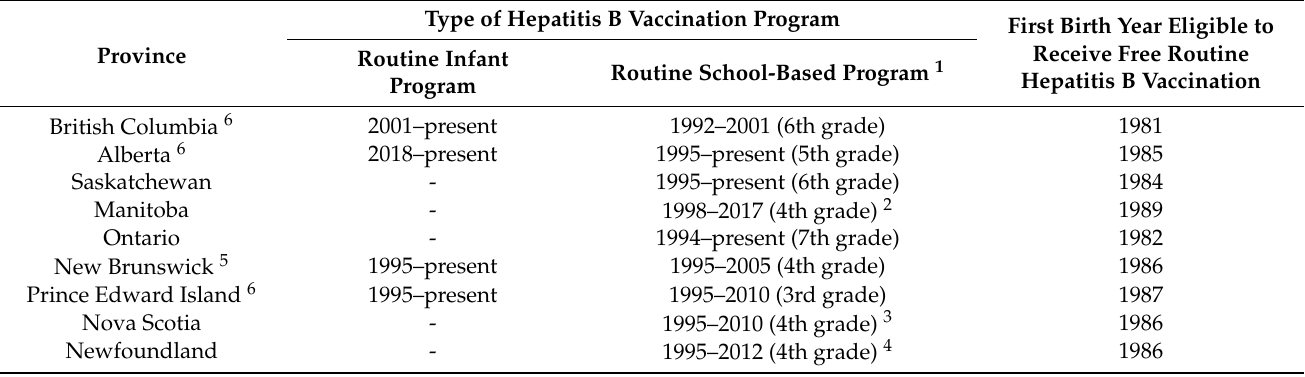
Table 1. Calendar years when free routine hepatitis B programs have been offered, and the first birth year with routine hepatitis B vaccination programs by province in Canada.